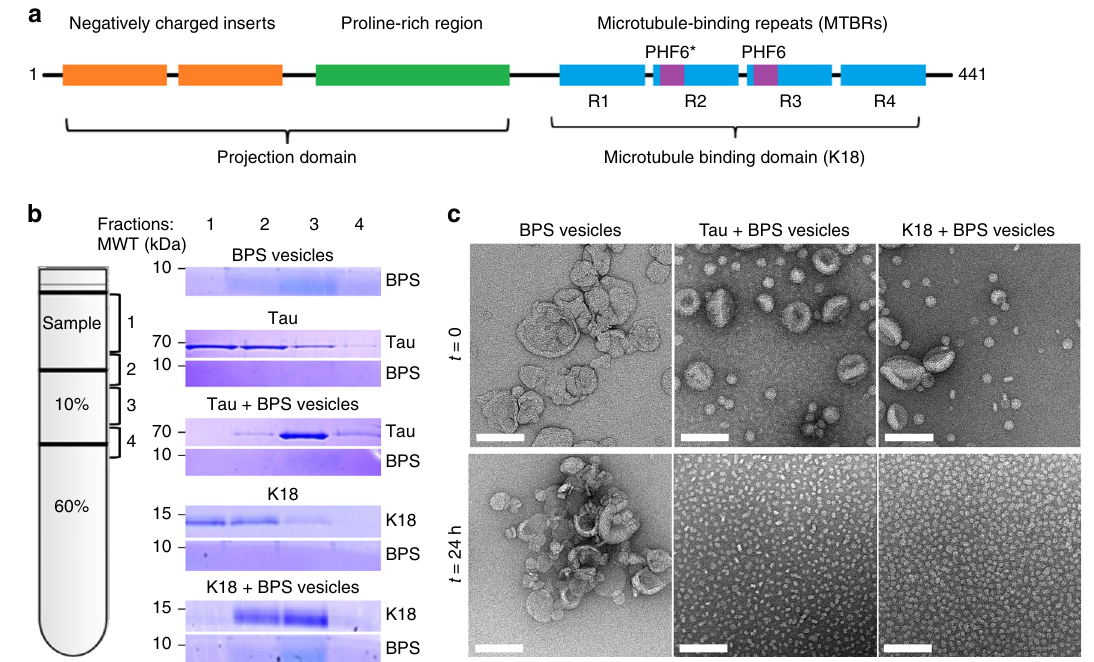
Fig. 1 Tau and K18 bind to and disrupt vesicles formed with negatively charged phospholipids, resulting in the formation of globular Tau/K18-phospholipid complexes. a Schematic depiction of the Tau sequence. The longest Tau isoform consists of an N-terminal projection domain containing two negatively charged inserts, N1 and N2 (orange), and a proline-rich region (green), and a C-terminal microtubule-binding domain with four microtubule-binding repeats, R1 − R4 (blue). R2 and R3 contain the hexapeptides PHF6* and PHF6 (purple), respectively, which are necessary to drive Tau fi brilization. b Left: schematic representation of the vesicle sedimentation assay set-up; fraction 1: sample containing no sucrose, fraction 2: interface between sample and 10% sucrose solution, fraction 3: 10% sucrose solution, fraction 4: interface between 10 and 60% sucrose solutions. Right: SDS-PAGE analysis of the different fractions for different samples. c Negative-stain EM images of BPS vesicles alone (left) and mixed with Tau (middle) and K18 (right) at a molar protein: phospholipid ratio of 1:20 immediately after mixing (top panels) and after 24 h of incubation (bottom panels). The scale bars are 100